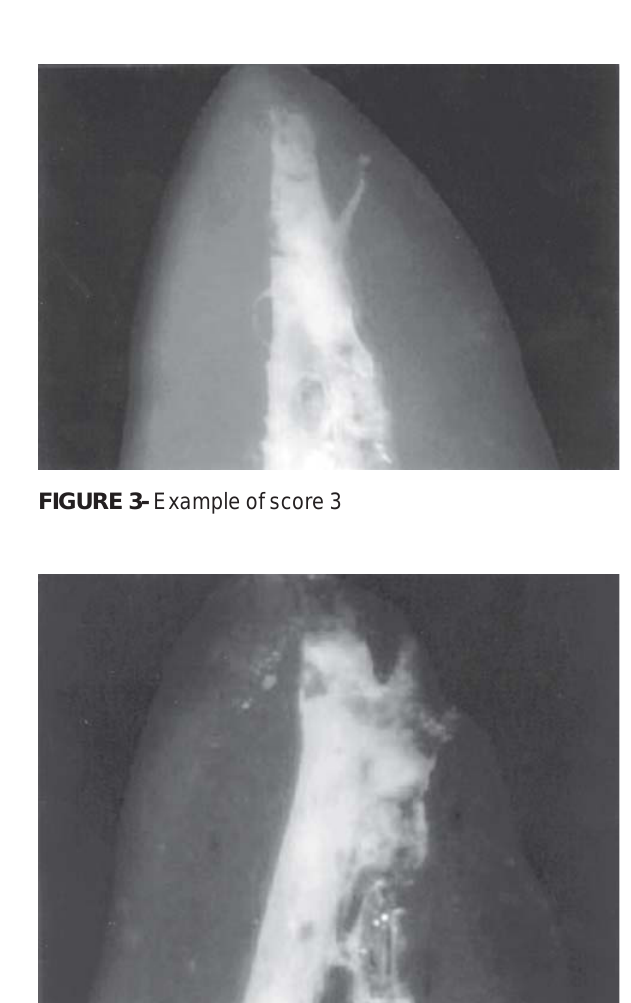
FIGURE 2- Example of score 2